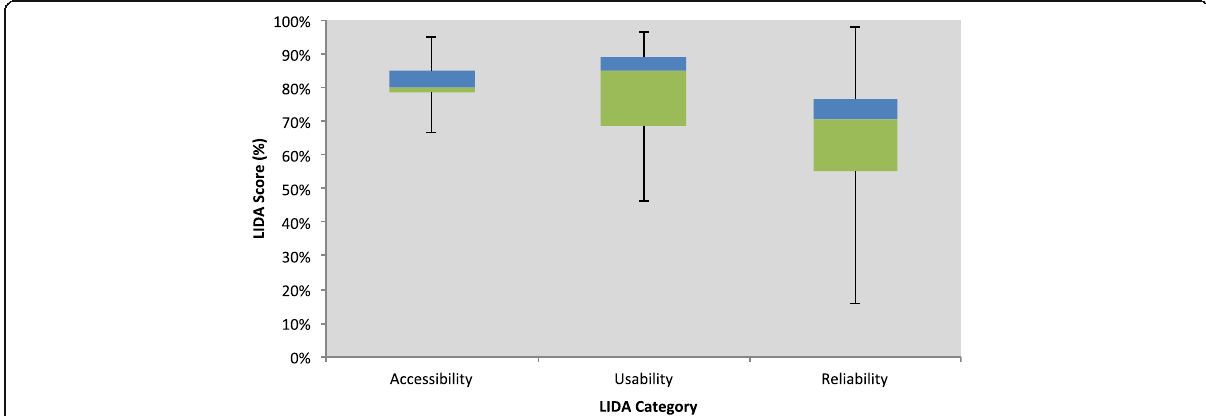
Fig. 3 Box-and-whisker plot of the distribution of LIDA scores (%) for each LIDA category in all